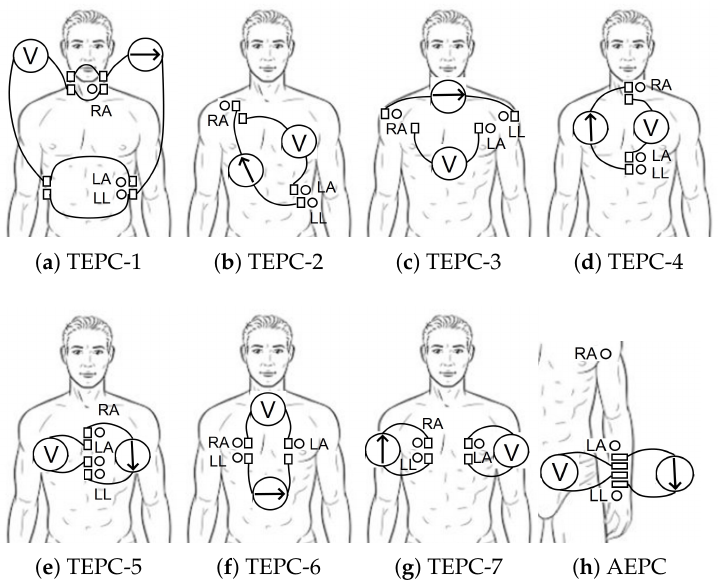
Figure 4. Measurement configuration setups: TEPC-1 to TEPC-7 (where the signal acquiring tech- nique for ICG with excitation (arrow, denoting the direction of current) and measurement (letter V) parts in line with the electrode placement of ECG) are shown (modified from [12]) and AEPC. For reference, in the cases of the same ICG electrode locations, ECG was picked up also with a standard 3-electrode system (where a single lead was considered in signal analysis). In such case, the positive left arm (LA) electrode, right arm negative (RA) electrode, and left leg (LL) electrode were attached with equal distances on the thorax, constituting a standard ECG monitoring approach (Figure 5a). A respectively monitored signal of ECG is visible in Figure